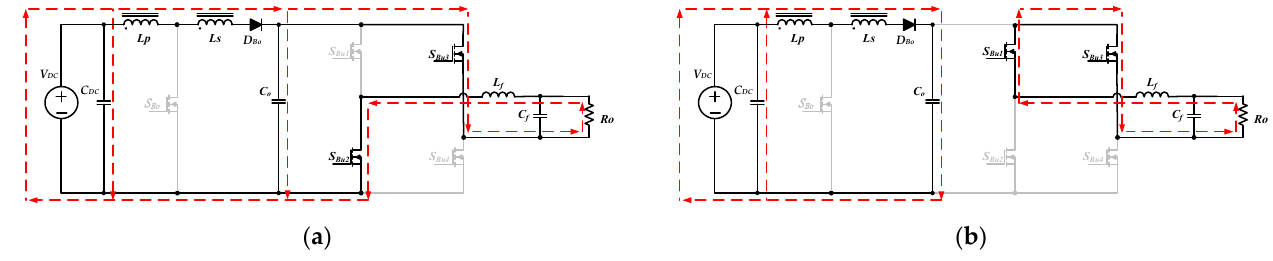
Figure 7. The equivalent circuits of the inverter operating in step-down mode during the negative half-cycle: ( a ) S Bu 1 off and S Bu 2 on; ( b ) S Bu 1 on and S Bu 2 off.